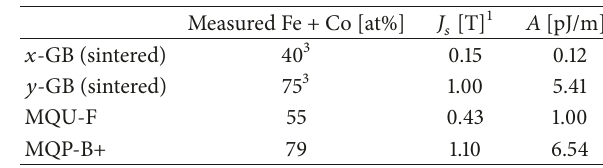
Table 3: Measured Fe + Co content in GBs in sintered and melt- spun Nd-Fe-B magnets and resulting magnetic